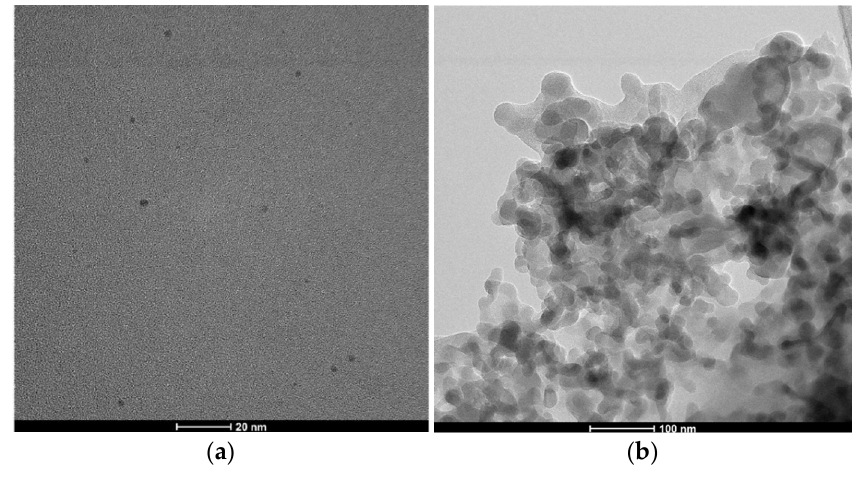
Figure 1. HR-TEM images for ( a ) CD 0 and ( b ) CD F .